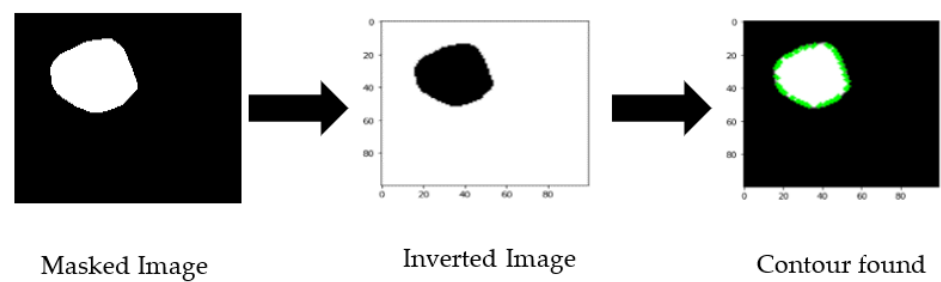
Figure 3. Masked image processing sequence.